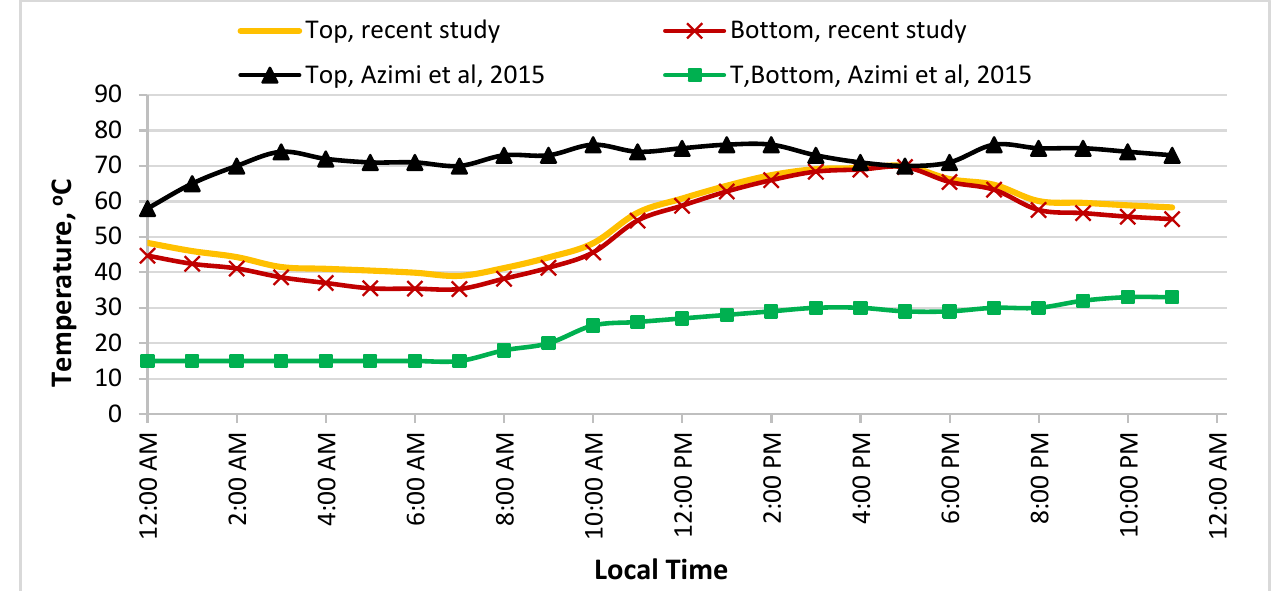
Figure 10. Temperature distribution of water through the top and bottom of the storage tank.